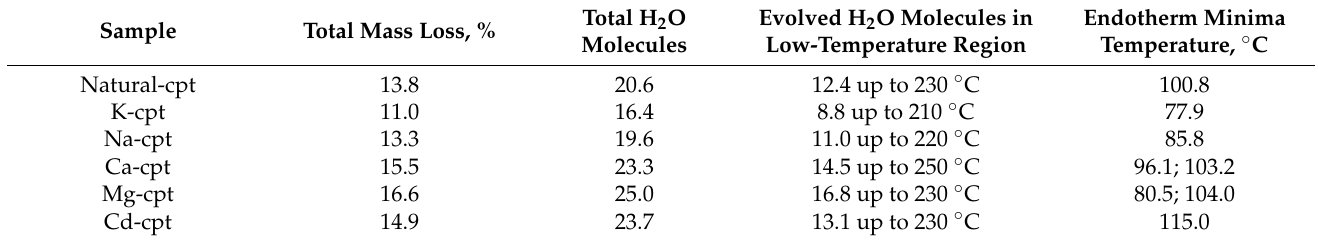
Table 2. Thermal analyses data of the natural and ion-exchanged forms of clinoptilolite.